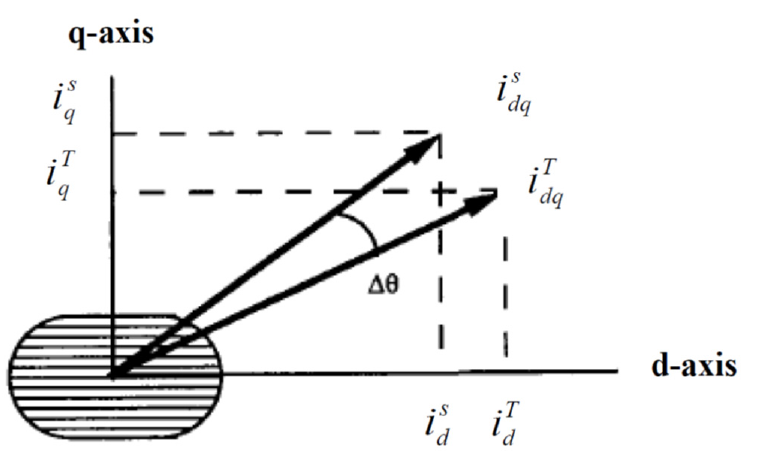
Figure 2. The relationship between torque current and terminal current vector, adopted from [34]. It can be seen that the lack of attention to the distinction between these two vectors causes a permanent error in torque, and the full realization of different strategies for con- trolling the torque of the reluctance synchronous motor, such as maximizing the efficiency (MEC) and controlling the maximum torque to the current (MTPA) and minimum